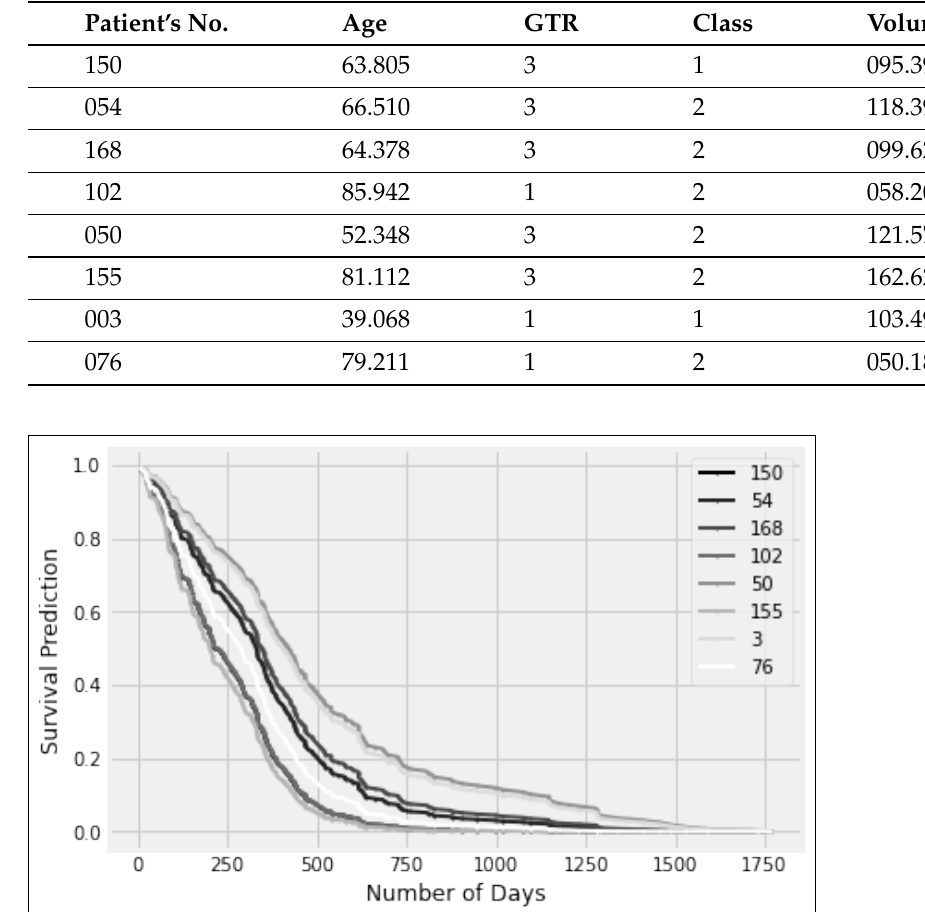
Table 9. Sample input data for survival prediction.